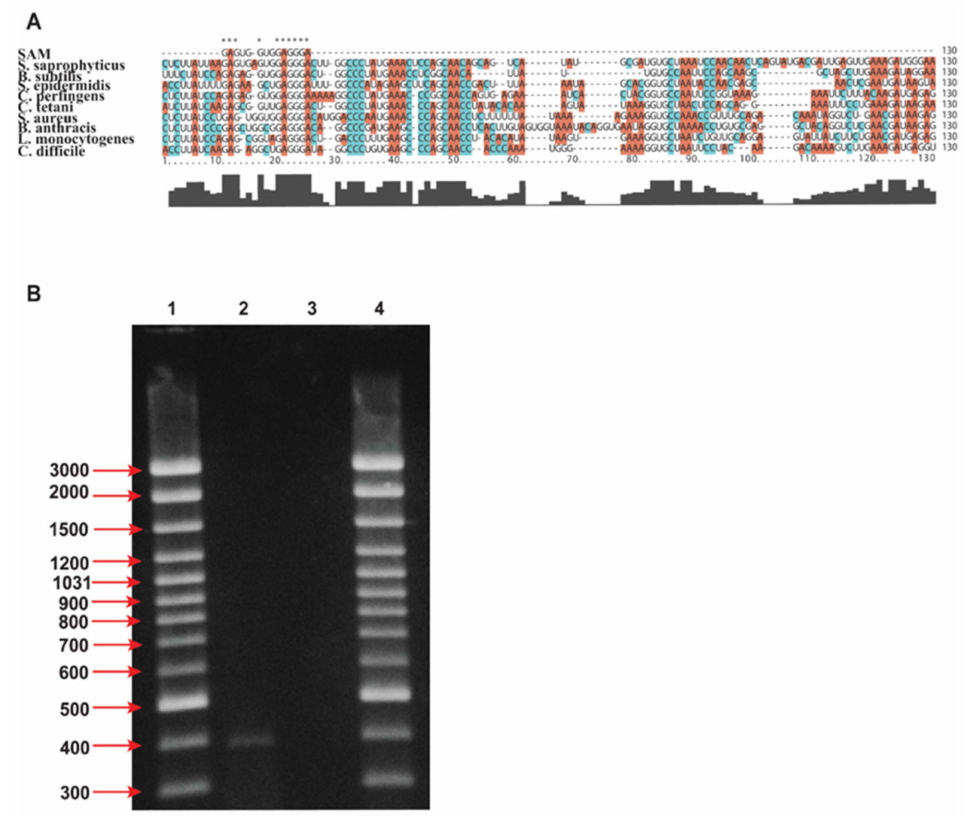
Figure 2. ( A ) Alignment of the sequences in pathogenic bacteria containing the SAM-I riboswitch sequence. The pathogenic bacteria S. aureus, S. sapropyticus, S. epidermidis, L. monocytogenes, C. tetani, C. perfingens, C. difficile, B. anthracis , and the non-pathogenic bacteria B. subtilis contains the SAM-I riboswitch sequence. The same color has the same nucleotide. ( B ) Gel electrophoresis of the SAM-I aptamer RNA from S. aureus. Total RNA is isolated and converted into cDNA. Two primers were used to amplify a SAM-I aptamer region targeted by the pVEC-AS0-1 (1) Determining the size of the DNA by 1000 bp. (2) The amplified cDNA from cells without treatment with pVEC-ASO-1. (3) The amplified cDNA treatment with